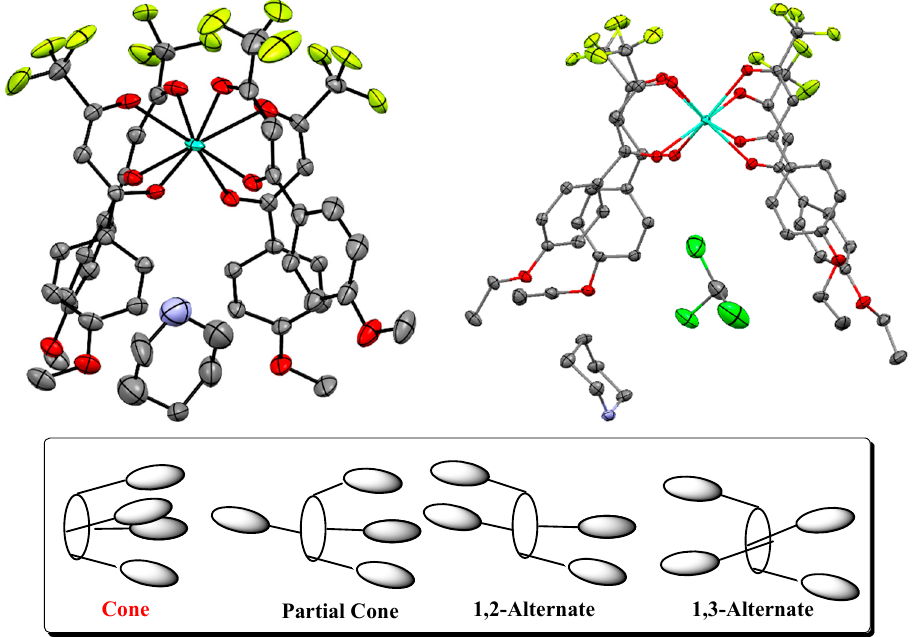
Cone 1,2-Alternate 1,3-AlternatePartial Cone Figure 4. ORTEP view of the complexes 2a ( left ) and 2b ( right ). Ellipsoids are drawn at 50% probability level. Aqua blue, palegreen, blue, red and green ellipsoids show Eu, F, N, O, and Cl atom(s), respectively.